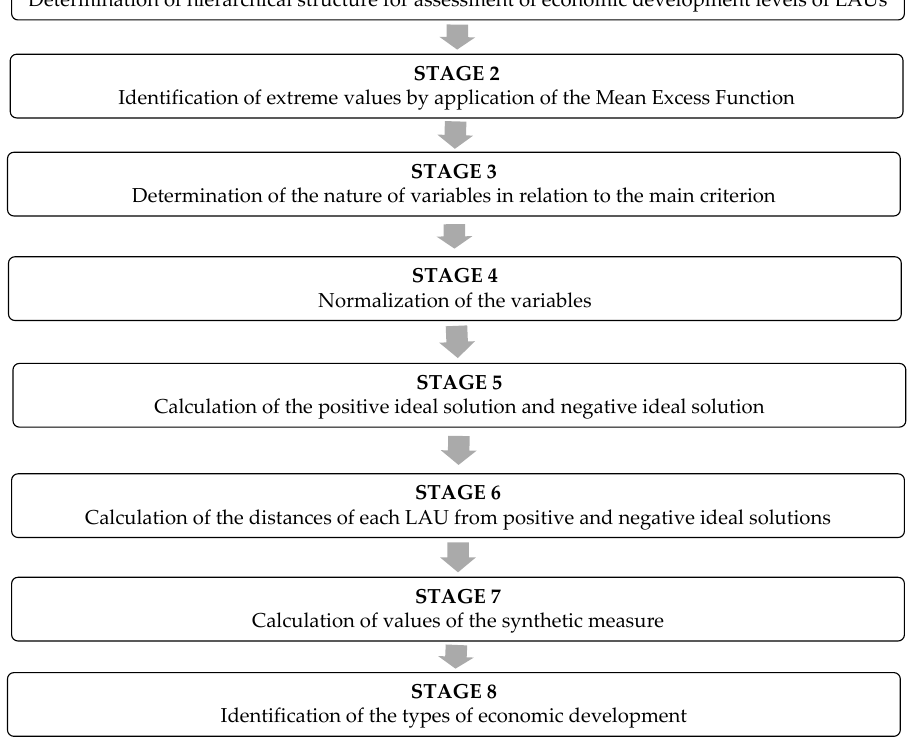
Figure 1. Procedure of construction of the synthetic measure.